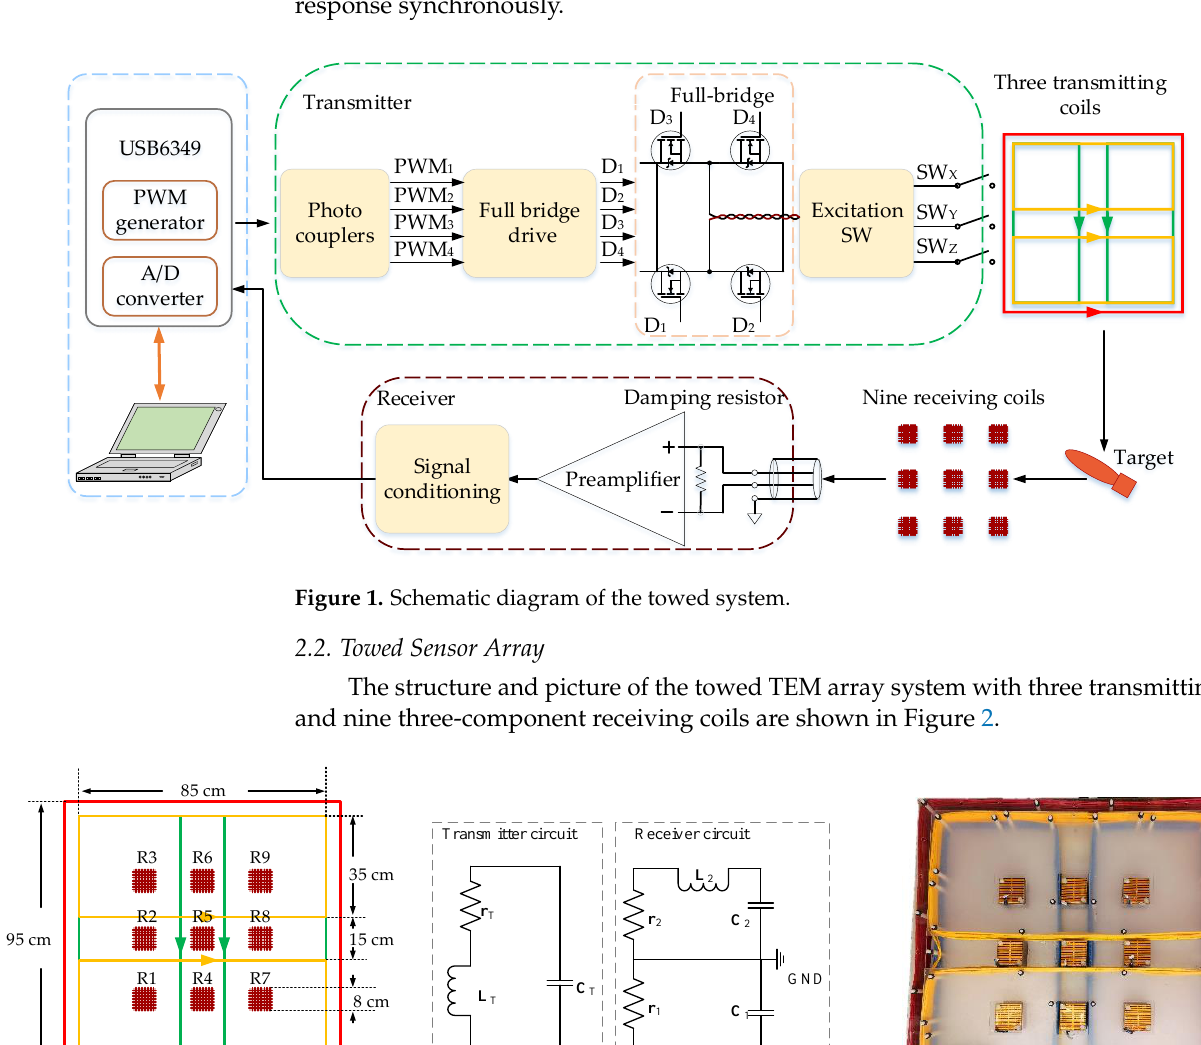
Figure 1. Schematic diagram of the towed system.